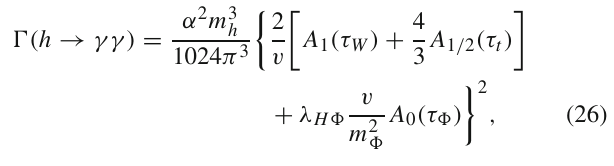
smallest value of λ H (cid:2) are interpolated using straight